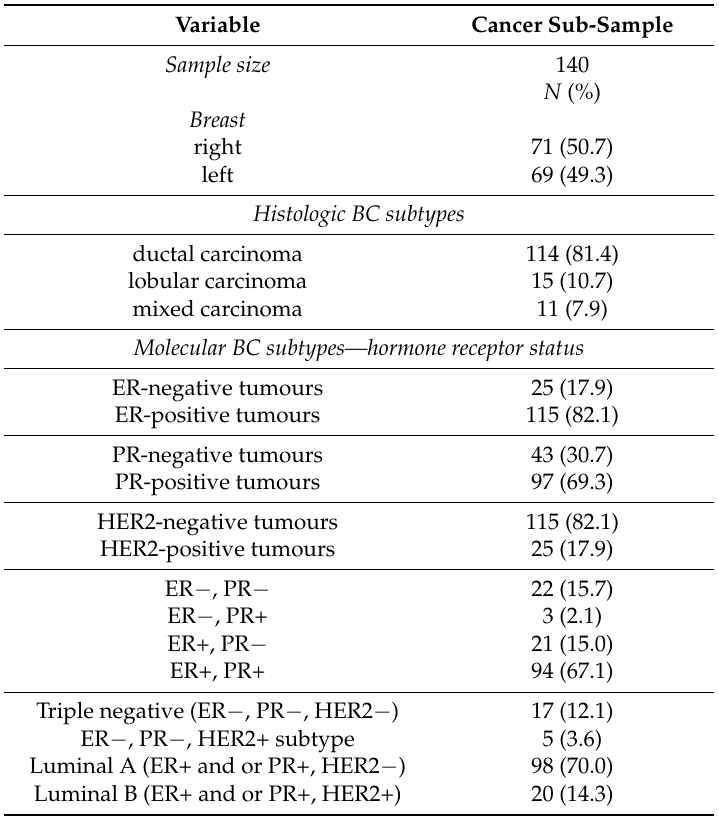
Table 1. Histologic and molecular subtypes of breast cancer sub-sample.